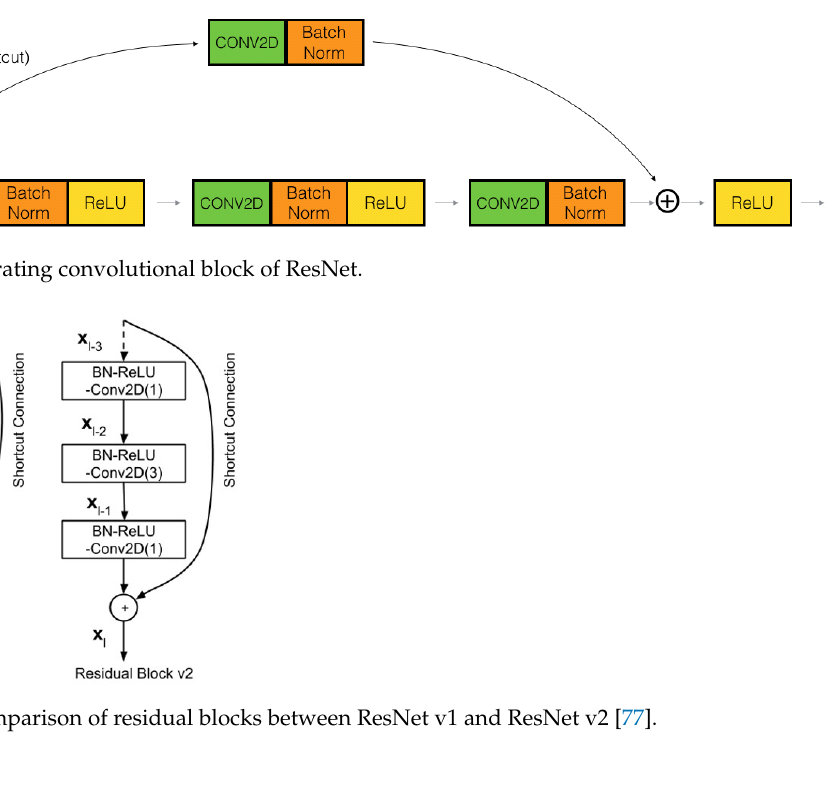
Figure 7. A Residual Block across two layers of ResNet.